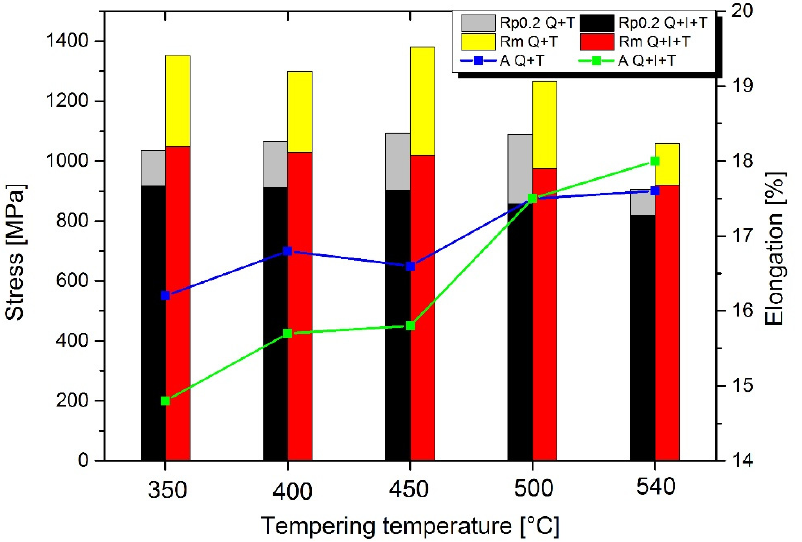
Figure 5. Yield strength (Rp 0.2 ), tensile strength (Rm) and elongation (A) of Q + T and Q + I + T specimens at different annealing temperatures.